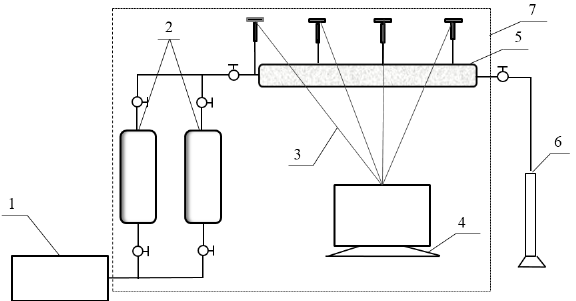
Fig. 1. Diagram of the sandpack flow process. 1-Plunger pump; 2-container; 3- pressure taps; 4- analysis computer; 5-sandpack; 6-measuring cylinder; 7-